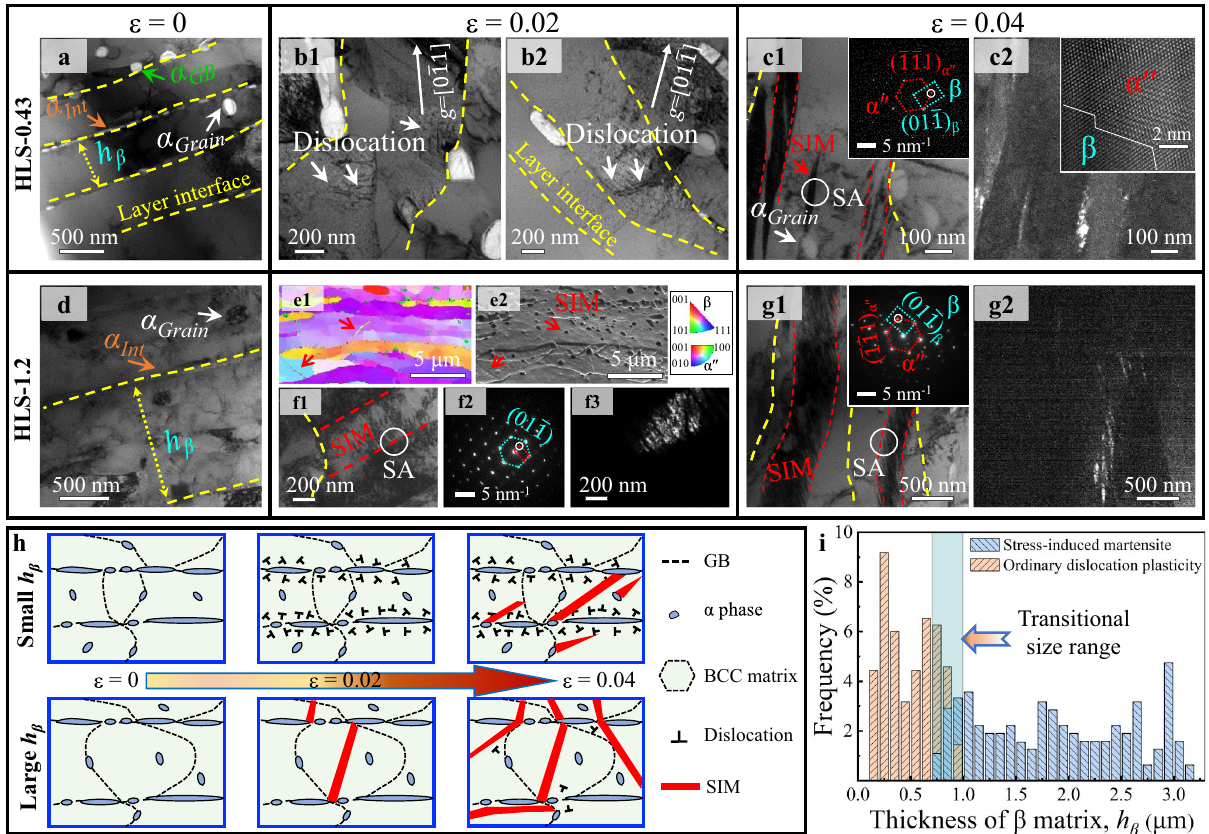
Fig. 1 | Deformationmechanisms in HLS-0.43and HLS-1.2 β -Tialloysactivated in the initial plastic deformation stage. a – c HLS-0.43 β -Ti alloys. a At a strain ɛ =0, a bright- fi eld TEM (BF-TEM) image shows the layered structure and multiple phases. b1-b2 Atastrain ɛ =0.02,dislocationsaregeneratedfromthe α / β interface andpileupagainsttheoppositeinterface,andnoSIMisobservedinthe β layers. c1 At a strain ɛ =0.04, a BF-TEM image shows SIM bands are nucleated from the α / β interface and in a region adjacent to α Grain inside the β -layer, indicated by red dashed linesand red arrow, respectively,whichareveri fi ed by theSAEDpatternin c1 . c2 TheDF-TEMimageof c1 .TheinsetisthecorrespondingHR-TEMimagein c2 , showingthe α ″ / β interfacehighlightedbythewhiteline. d – g HLS-1.2 β -Tialloys. d A